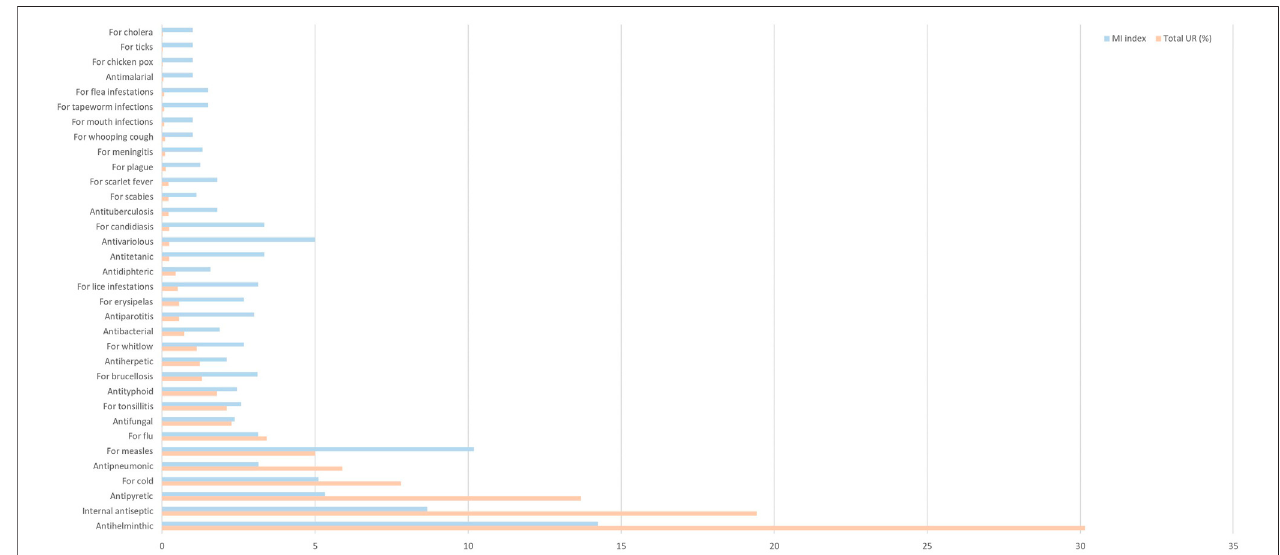
FIGURE 2 | Total use report percentage of medicinal uses to treat infections and infestations, and their medicinal importance (MI) index.